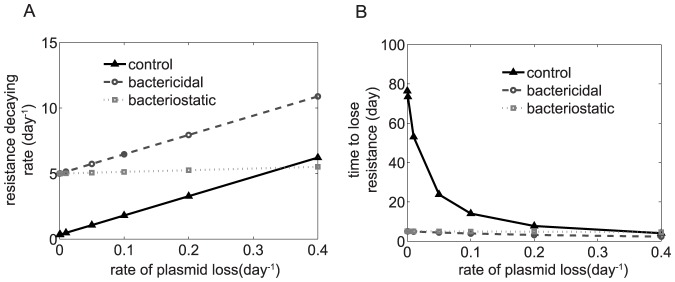
Resistance attenuation is influenced by the nature of antiR treatment and by the plasmid loss rate.The nature of the antiR treatment (whether bactericidal or bacteriostatic, see Text S1 in File S1) and the rate of plasmid loss influence the dynamics of resistance attenuation. We illustrate the resistance decaying rate (A) and tclear (B) as a function of the rate of plasmid loss and the nature of treatment. At low rates of plasmid loss (ρ≈0), antiR treatment increases the resistance attenuation by a factor ∼15, independently of the nature of antiR treatment. Values are estimated according to data published in [33].